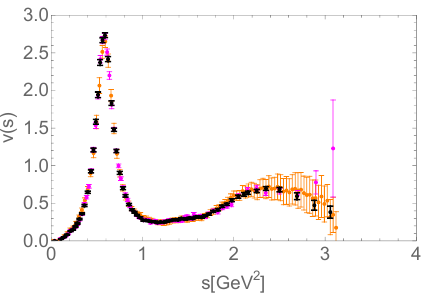
Figure 1. ALEPH (magenta) and OPAL (orange) vector spectral functions, v( s ) = 2 π Im Π ( s ), together with the improved combined result of Ref. [21] described in the text (black).